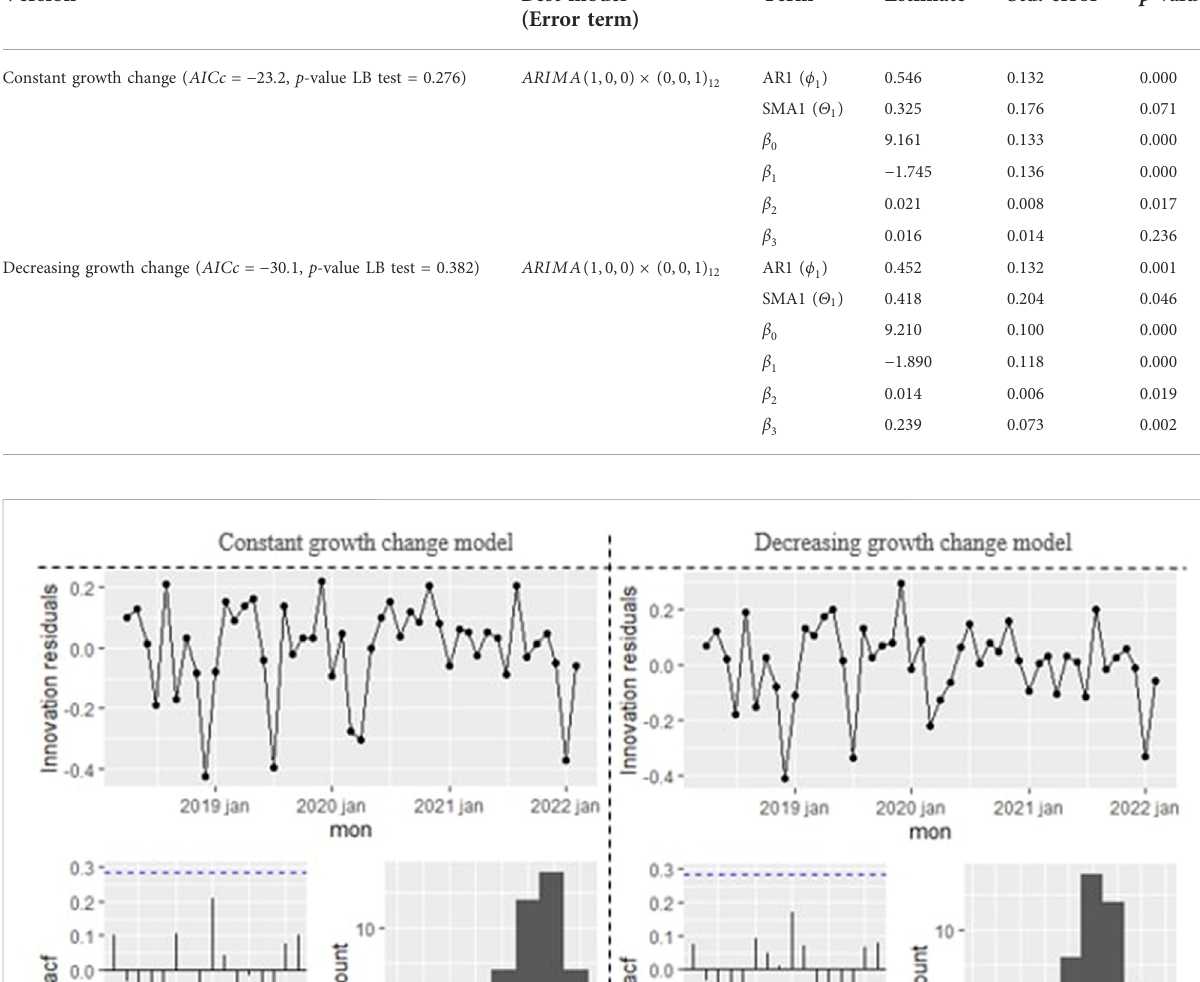
TABLE 1 Coef fi cients of the ITS-ARIMA models. Version